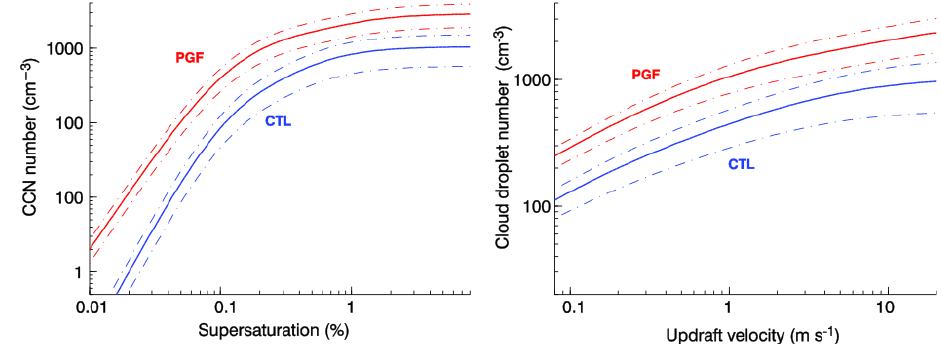
Figure 10. Left: cumulative median CCN supersaturation spectrum PGF periods (blue) and CTL (yellow). Dashed lines approximate the interquartile range. Right: as in left but for predicted cloud droplet number concentration as a function of updraft